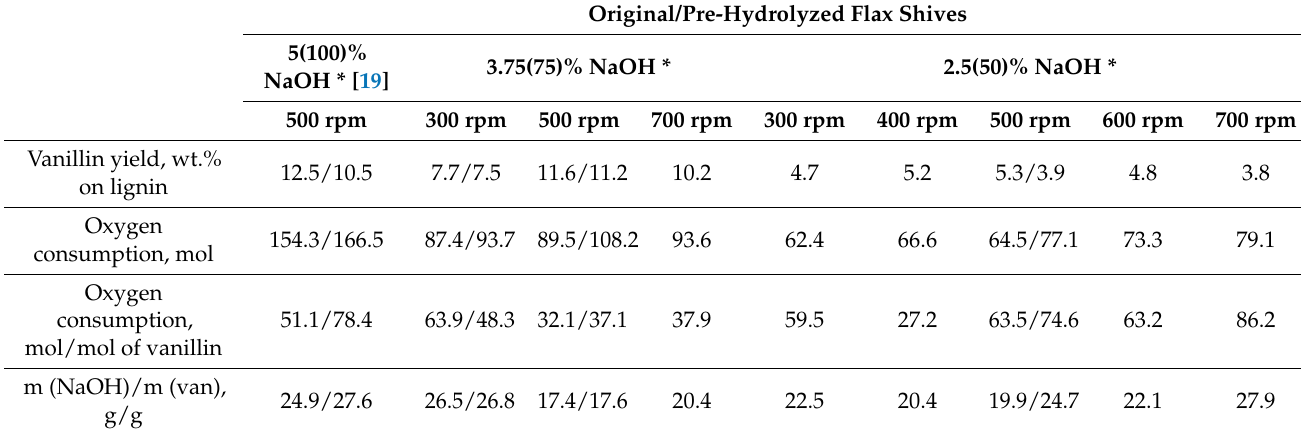
Table 2. Influence of the stirring speed and the alkali loading on the product yield and the consump- tion of reagents during the oxidation of Belarusian flax